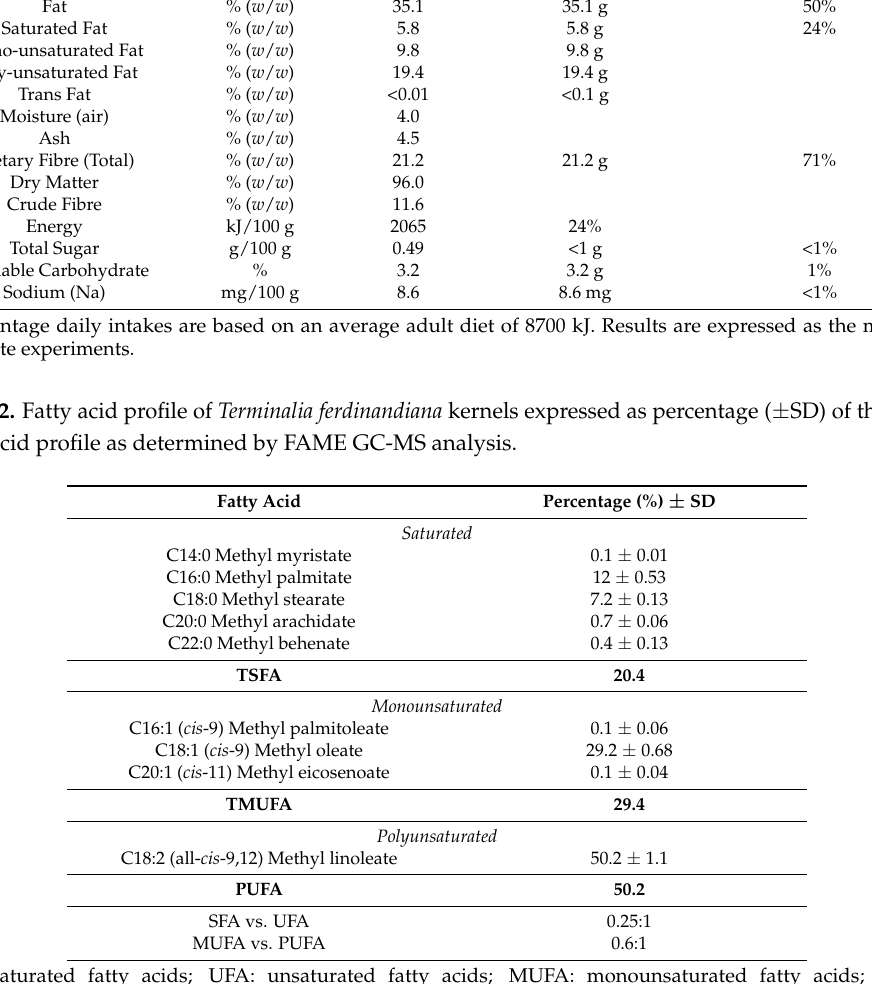
Nutrition Information (Servings per Package: 1) (Serving Size: 100 g)